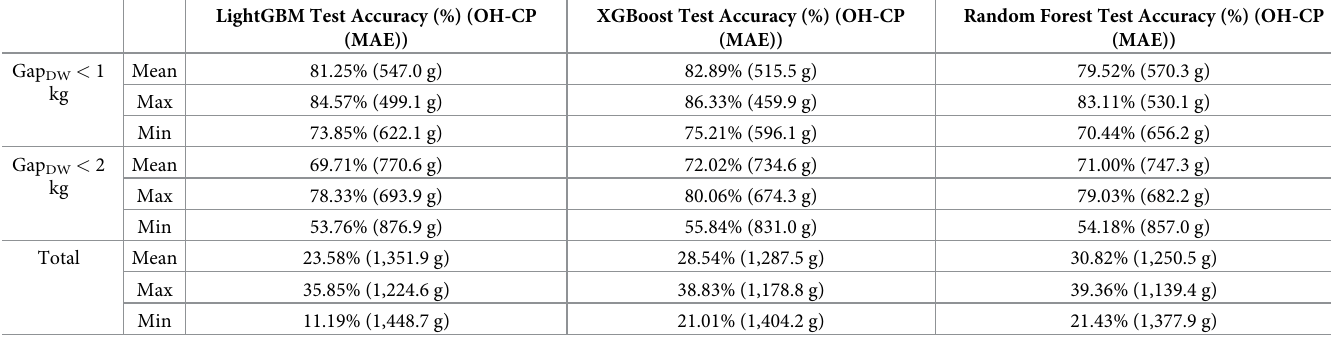
Table 2. Prediction using machine